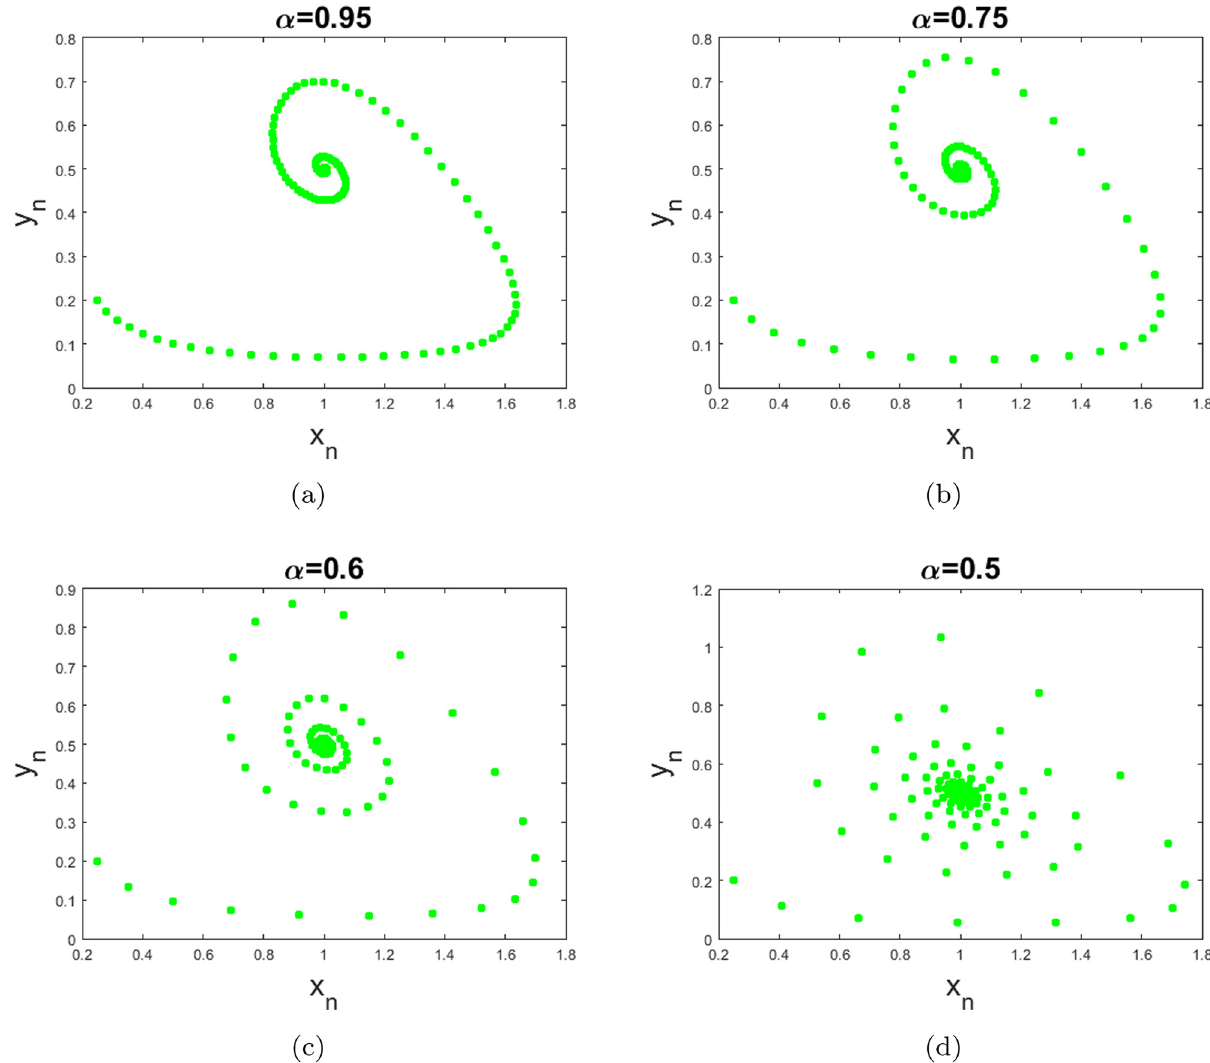
Figure 2: Stable dynamical behavior of system ( 22 ) subject to the initial condition ( ( ) ( )) ( ) = x y 0 , 0 0.25, 0.2 for the parameters = = = p q h 0.5, 1, 0.15, and = r 1 : ( a ) = α 0.95 , ( b ) = α 0.75 , ( c ) = α 0.6 , and ( d ) = α 0.5